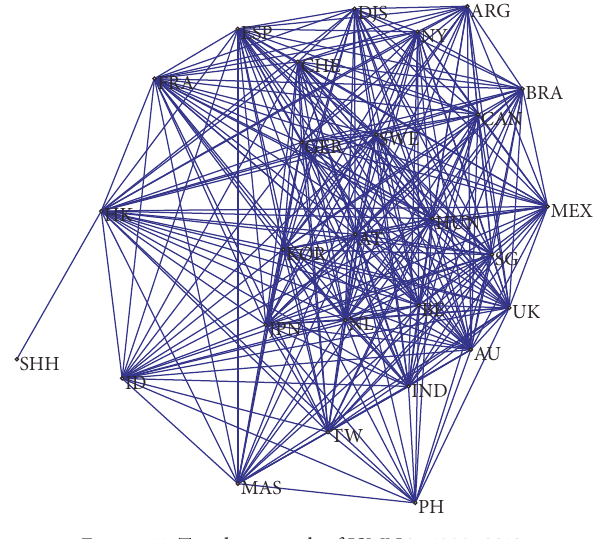
Figure 11: Topology graph of ISMN in 1999–2010.